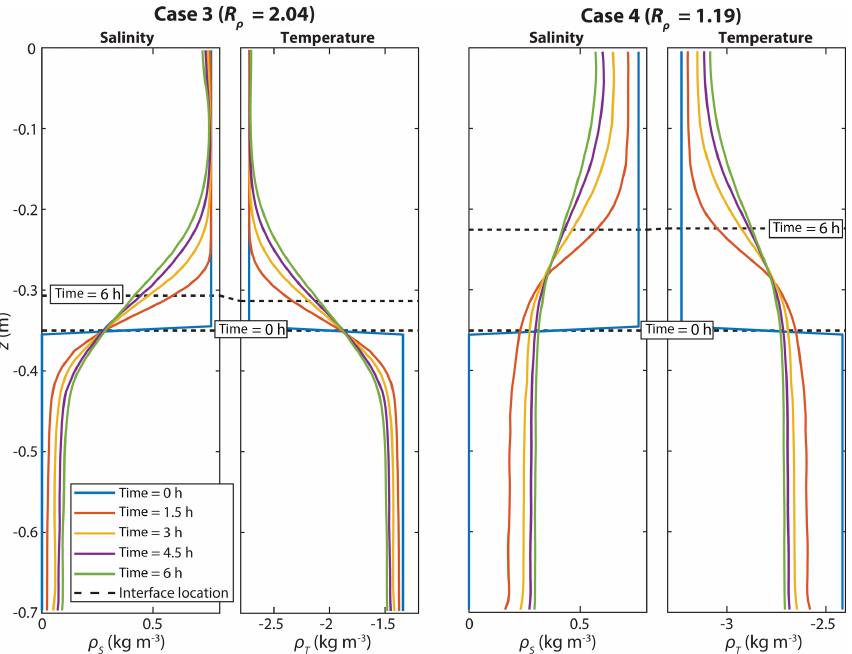
Figure 5. Interface positioning over time displayed on the depth profiles of S and T (both in kgm − 3 relative to the reference density) for the density ratios R ρ 2 . 04 (Case 3) and R ρ 1 . 19 (Case 4). The depth profiles are averaged over the complete horizontal domain and = = represent the simulations without a turbulence